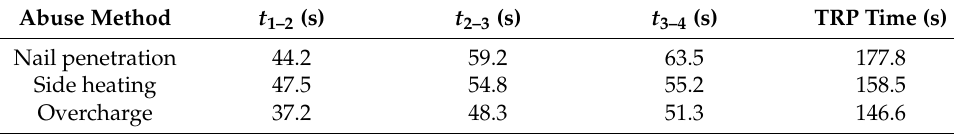
Table 3. Time interval of TRP with different trigger methods.